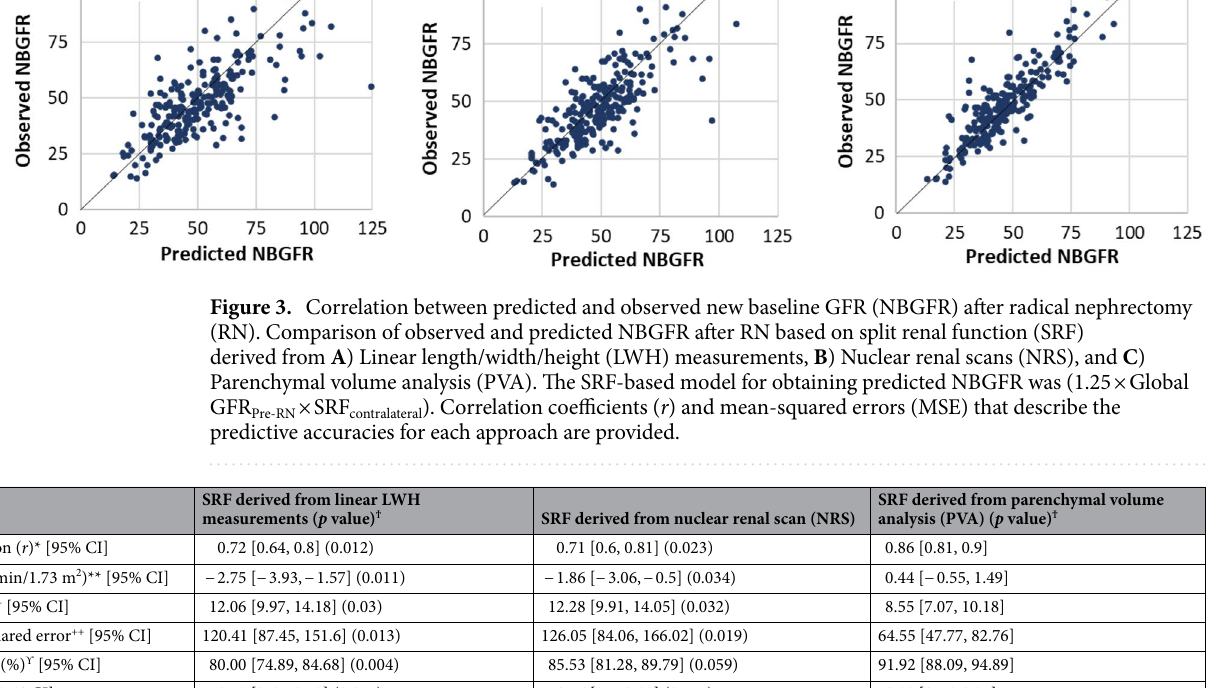
Table 2. Performance of various approaches for estimating NBGFR after radical nephrectomy using distinct split renal function-based approaches. AUC area under curve; CI confidence interval; NBGFR new baseline glomerular filtration rate; SRF split renal function. + Precision = interquartile range of bias (Q3 – Q1). + + Mean- squared error = Average of the square of the error (difference between predicted and observed NBGFR): 1 × (cid:31) n ( Y i − Y ∗ i ) 2 , where Y represents the model-predicted NBGFR and Y* represents the observed i = 1 n NBGFR. ϒ Accuracy = percentage of predicted NBGFR values within 30% of observed NBGFR. ϒϒ AUC values are obtained from ROC analyses that evaluate prediction of postoperative NBGFR > 45 ml/min/1.73 m 2 . Ϯ P value is for comparison with SRF derived from PVA. *Pearson correlation between predicted NBGFR and observed NBGFR. **Bias = median of residuals (observed NBGFR – predicted NBGFR).